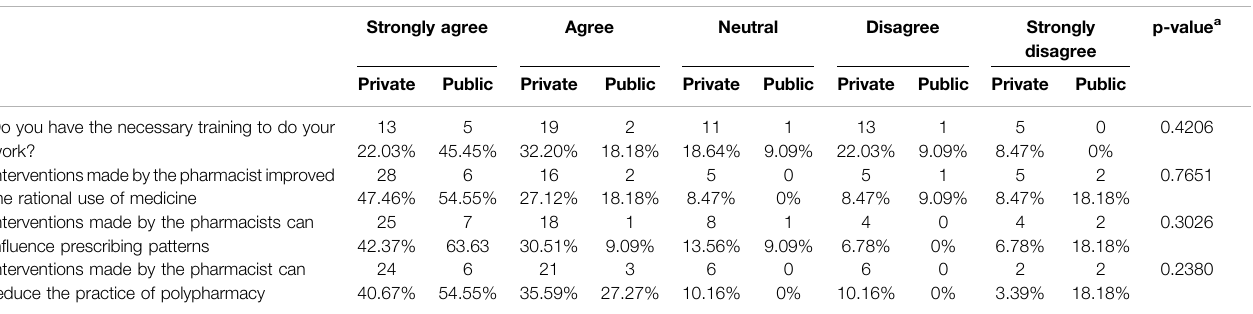
TABLE 2 | Perceptions of pharmacists.